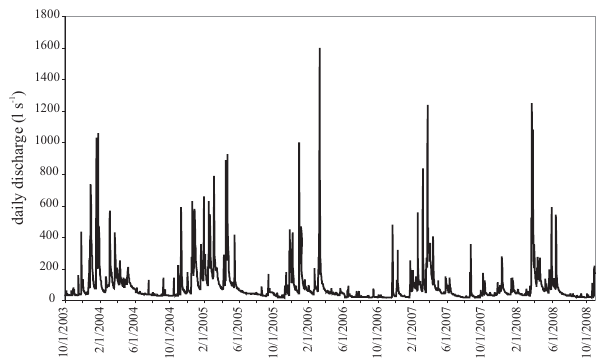
Fig. 2. Daily discharge recorded in Aixola gauging station during the study period (2003–2008).